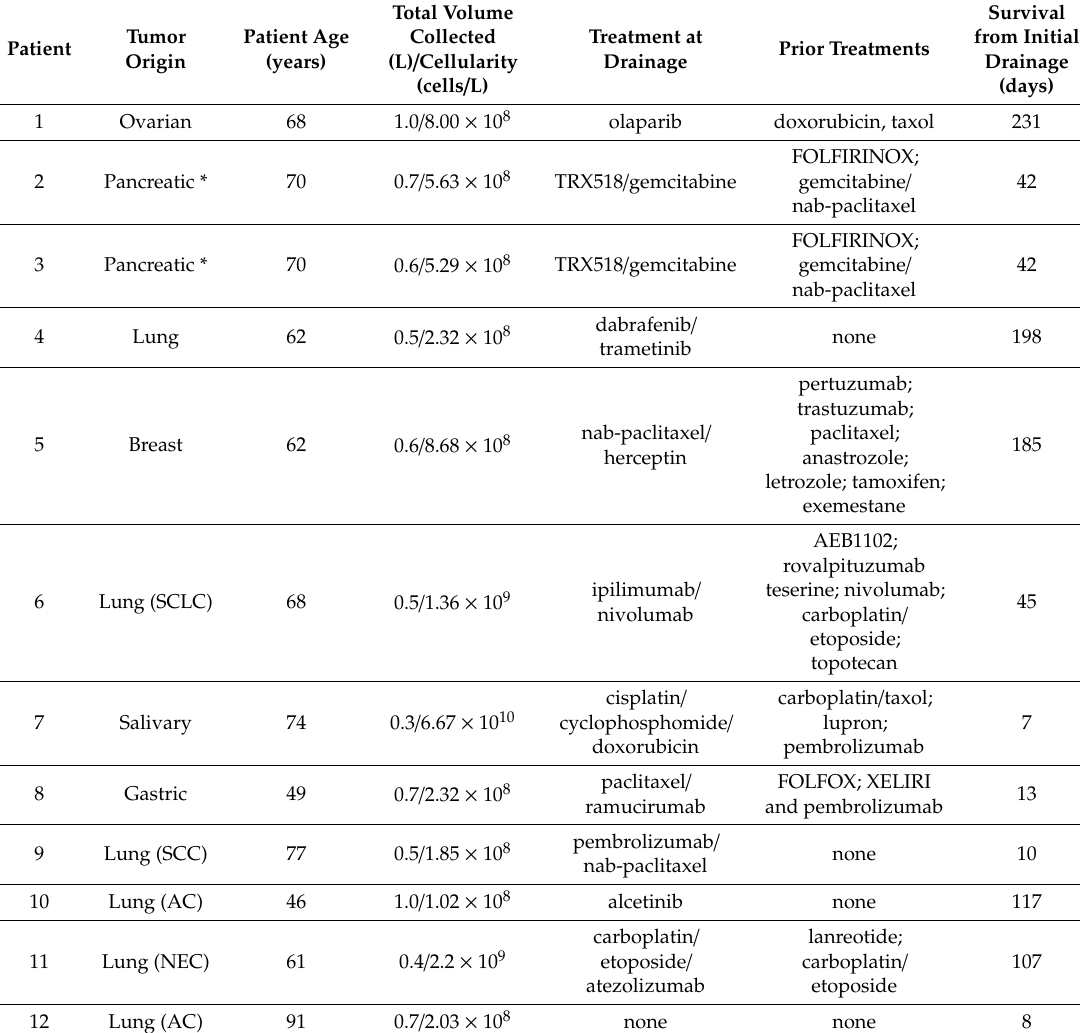
Table 1. Tumor types and clinical characteristics from 12 malignant pleural e ff